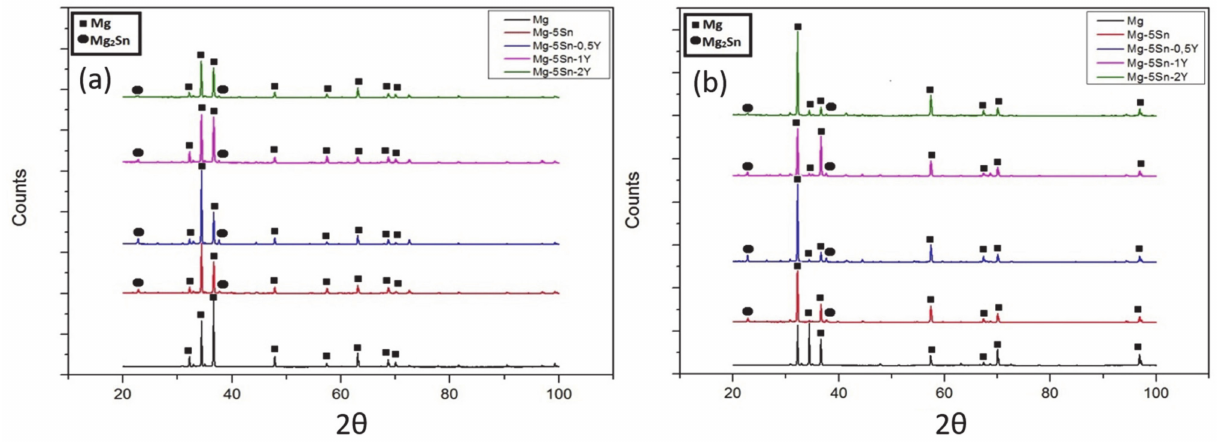
Figure 1. XRD diffractograms of as-extruded pure Mg and Mg-5Sn-xY (x = 0, 0.5, 1 and 2 wt.%) alloys along ( a ) longitudinal and ( b ) transverse direction.